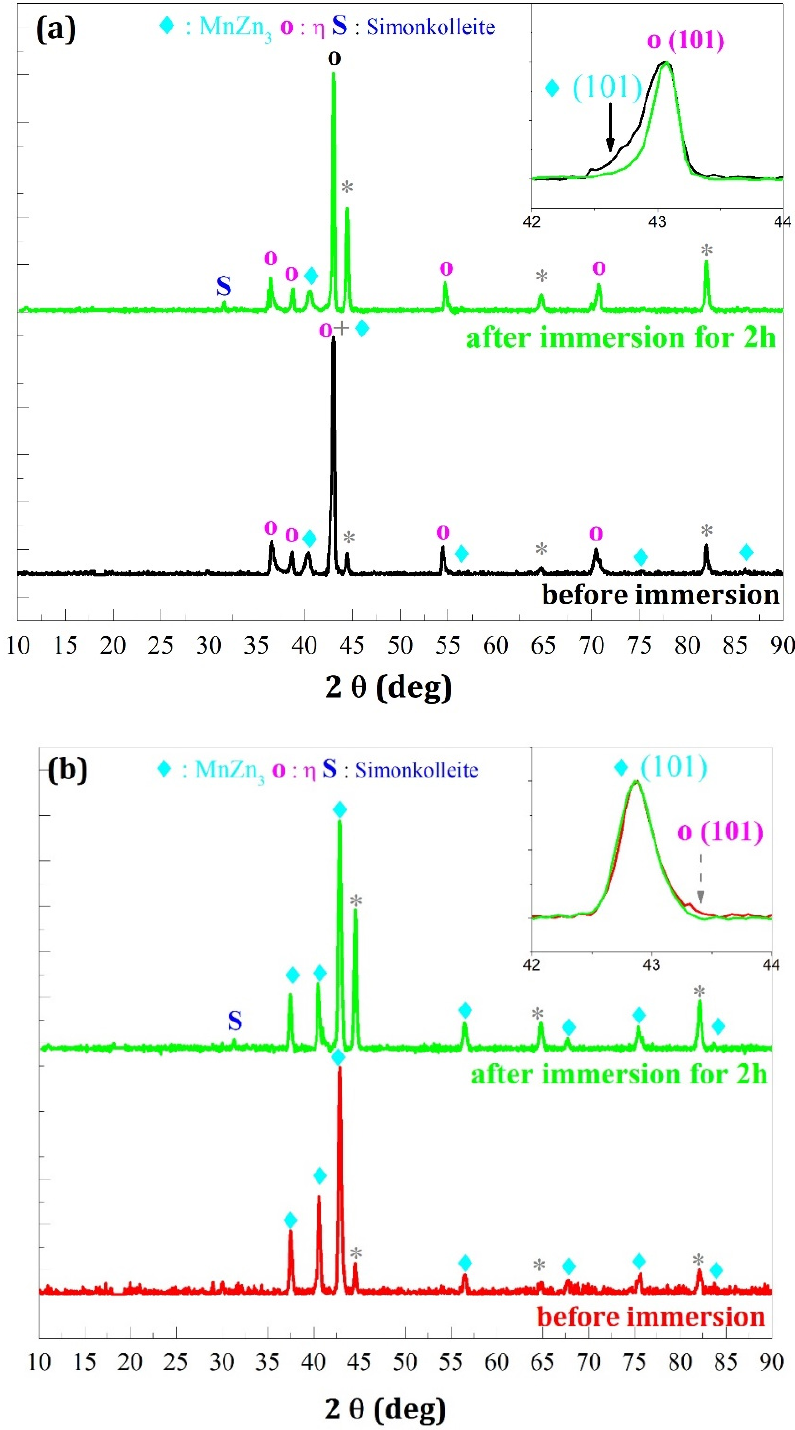
Figure 14. X-ray diffraction patterns of the deposits elaborated for B = 0 T and for two imposed potentials ( a ) E = − 1.6 V/SCE and ( b ) E = − 1.8 V/SCE before and after immersion for 2 h in 3.5% NaCl. Simonkolleite (JCPDS 00-007-0155), phases η (JCPDS = 96-901-3473), and MnZn 3 (JCPDS = 96-153-8161).